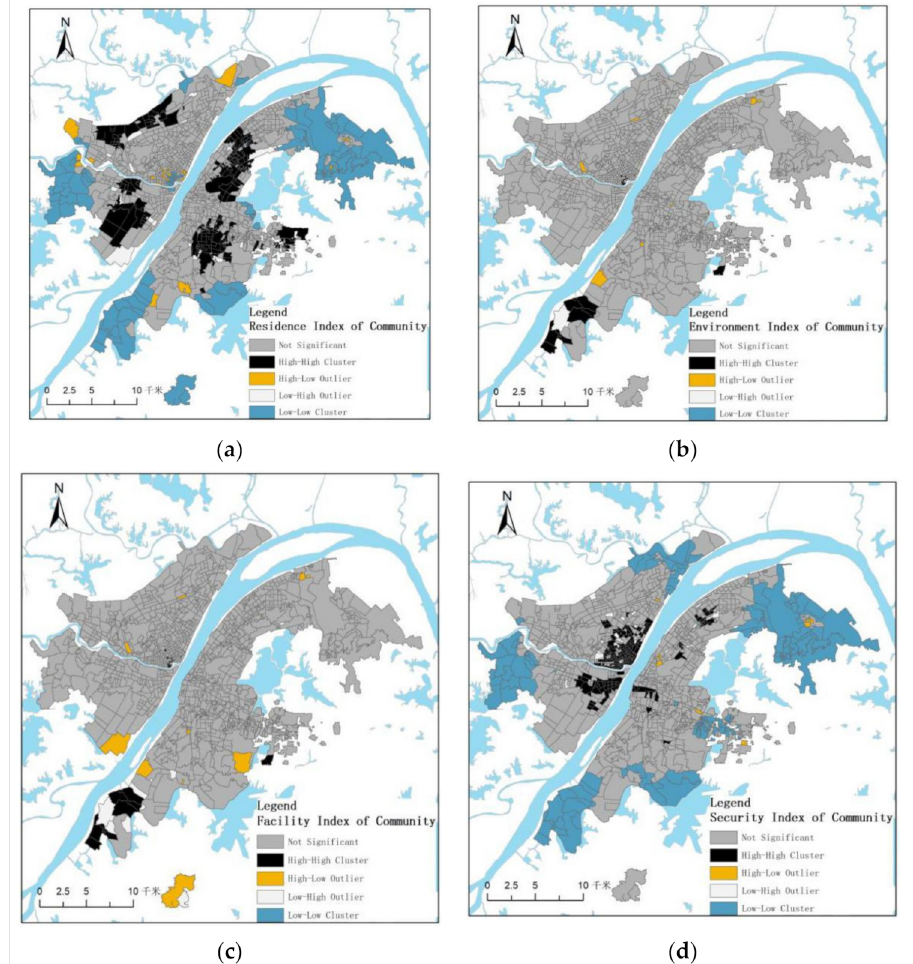
Figure 9. Spatial pattern of community livability:( a ) Hot and cold points of residence; ( b ) Hot and cold points of environment; ( c ) Hot and cold points of facility service; ( d ) Hot and cold points of security. It shows the statistical results of Anselin local Moran’s I by mapping hot and cold points. The black color represents the cluster around the high value, while the blue color represents the cluster around the low value, the yellow color represents the high value surrounded by low